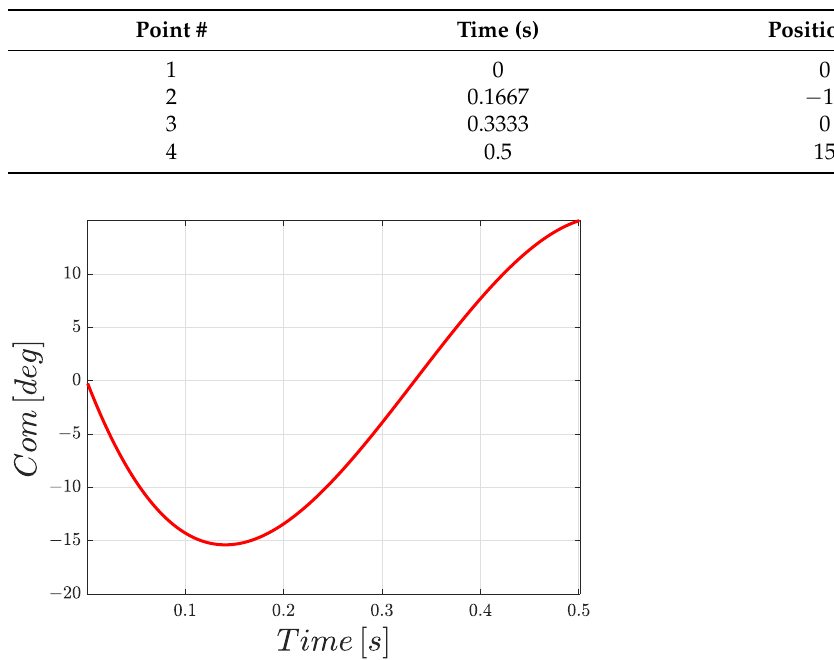
Table 1. Points used to define the third order polynomial command curve.